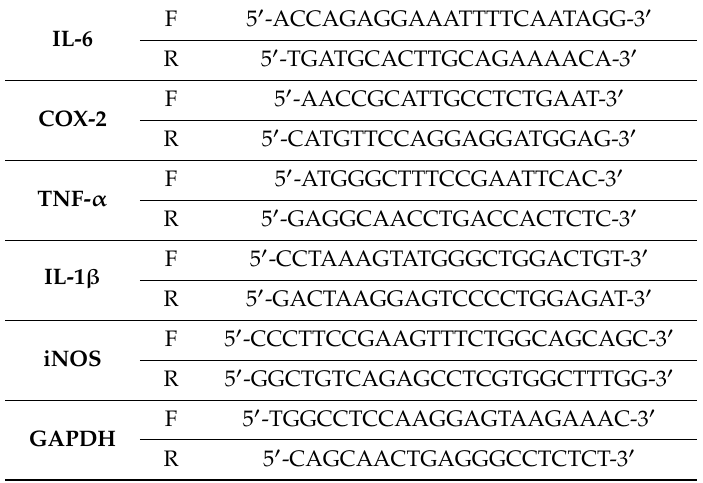
Table 2. Sequences of mRNA primers used in lipopolysaccharide (LPS)-stimulated RAW264.7 cells.